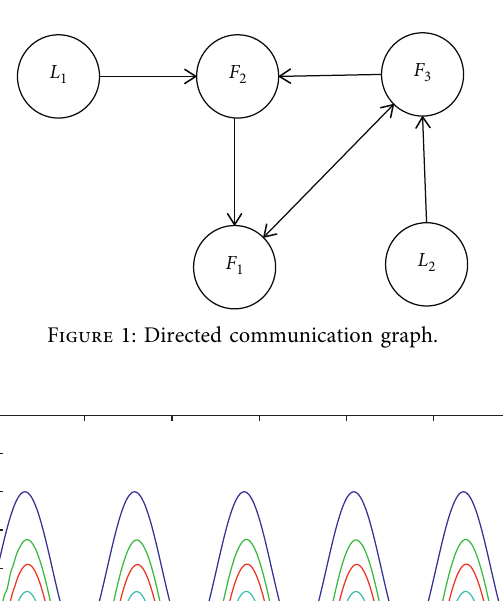
Figure 4: Curves of W